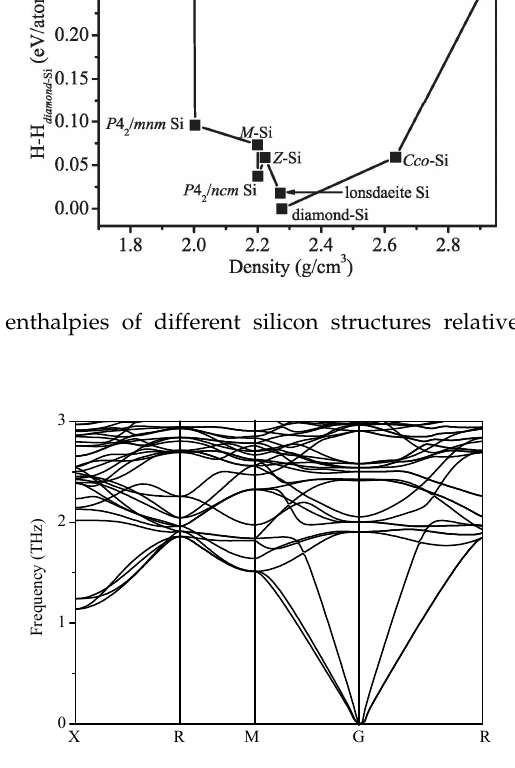
Figure 3. Phonon spectrum for Si 96 .